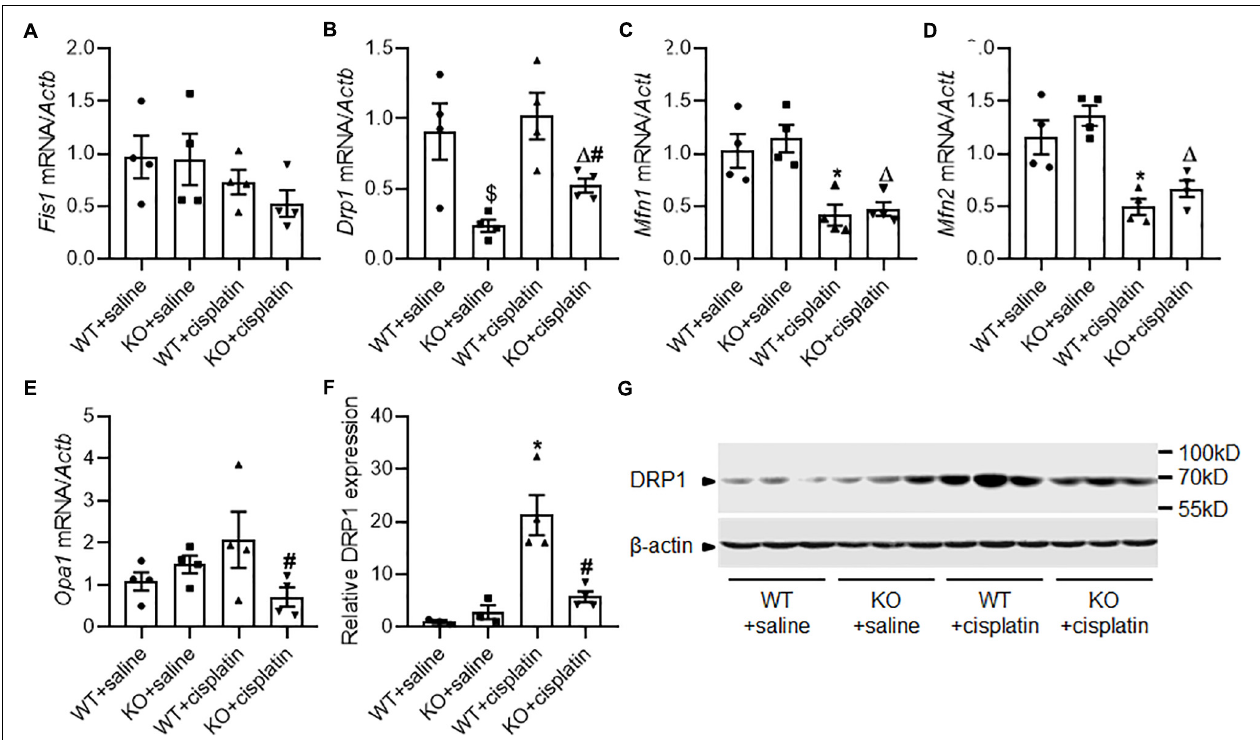
FIGURE 4 | The effect of PINK1 deficiency on mitochondrial dynamics related proteins during cisplatin treatment. (A–E) Real-time quantitative PCR analysis of Fis1 , Drp1 , Mfn1 , Mfn2 , and Opa1 mRNA expression in renal cortex. (F) Quantitative analysis of the western blotting of DRP1. (G) Representative western blot bands of DRP1 in renal cortex. N = 3 in WT + saline group and KO + saline group, N = 4 in WT + cisplatin group and KO + cisplatin group. ∗ P < 0.05, WT + cisplatin vs. WT + saline; # P < 0.05, KO + cisplatin vs. WT + cisplatin; (cid:49) P < 0.05, KO + cisplatin vs. KO + saline; $ P < 0.05, KO + saline vs. WT + saline. Data are mean ±